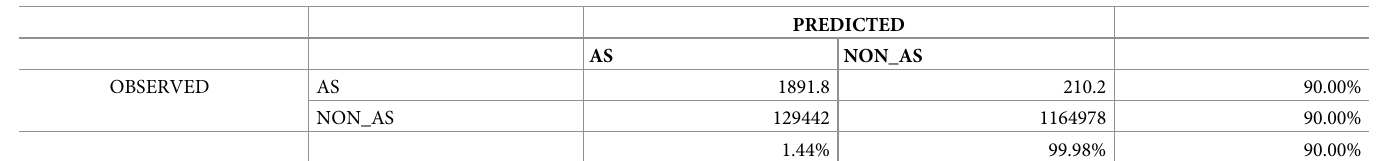
Table 7. Perfect model output (male).